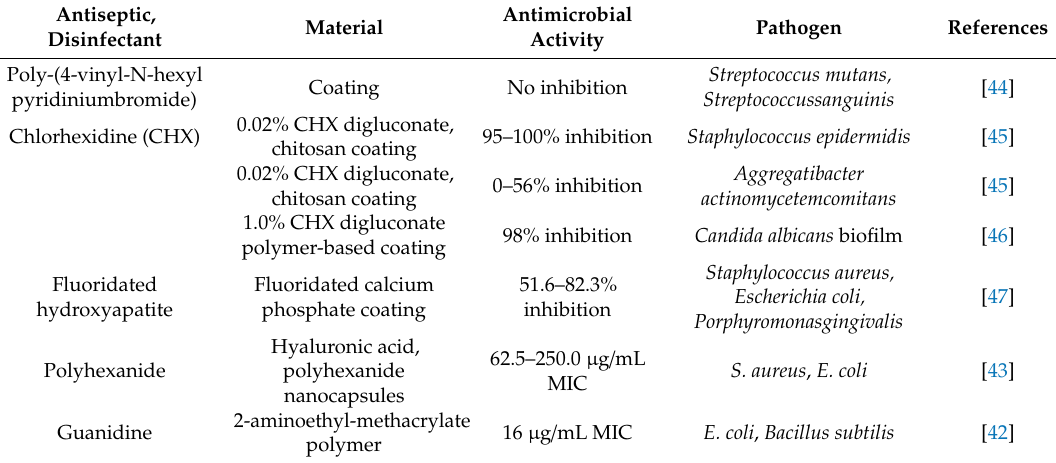
Table 2. Antiseptics and disinfectants used in bioactive